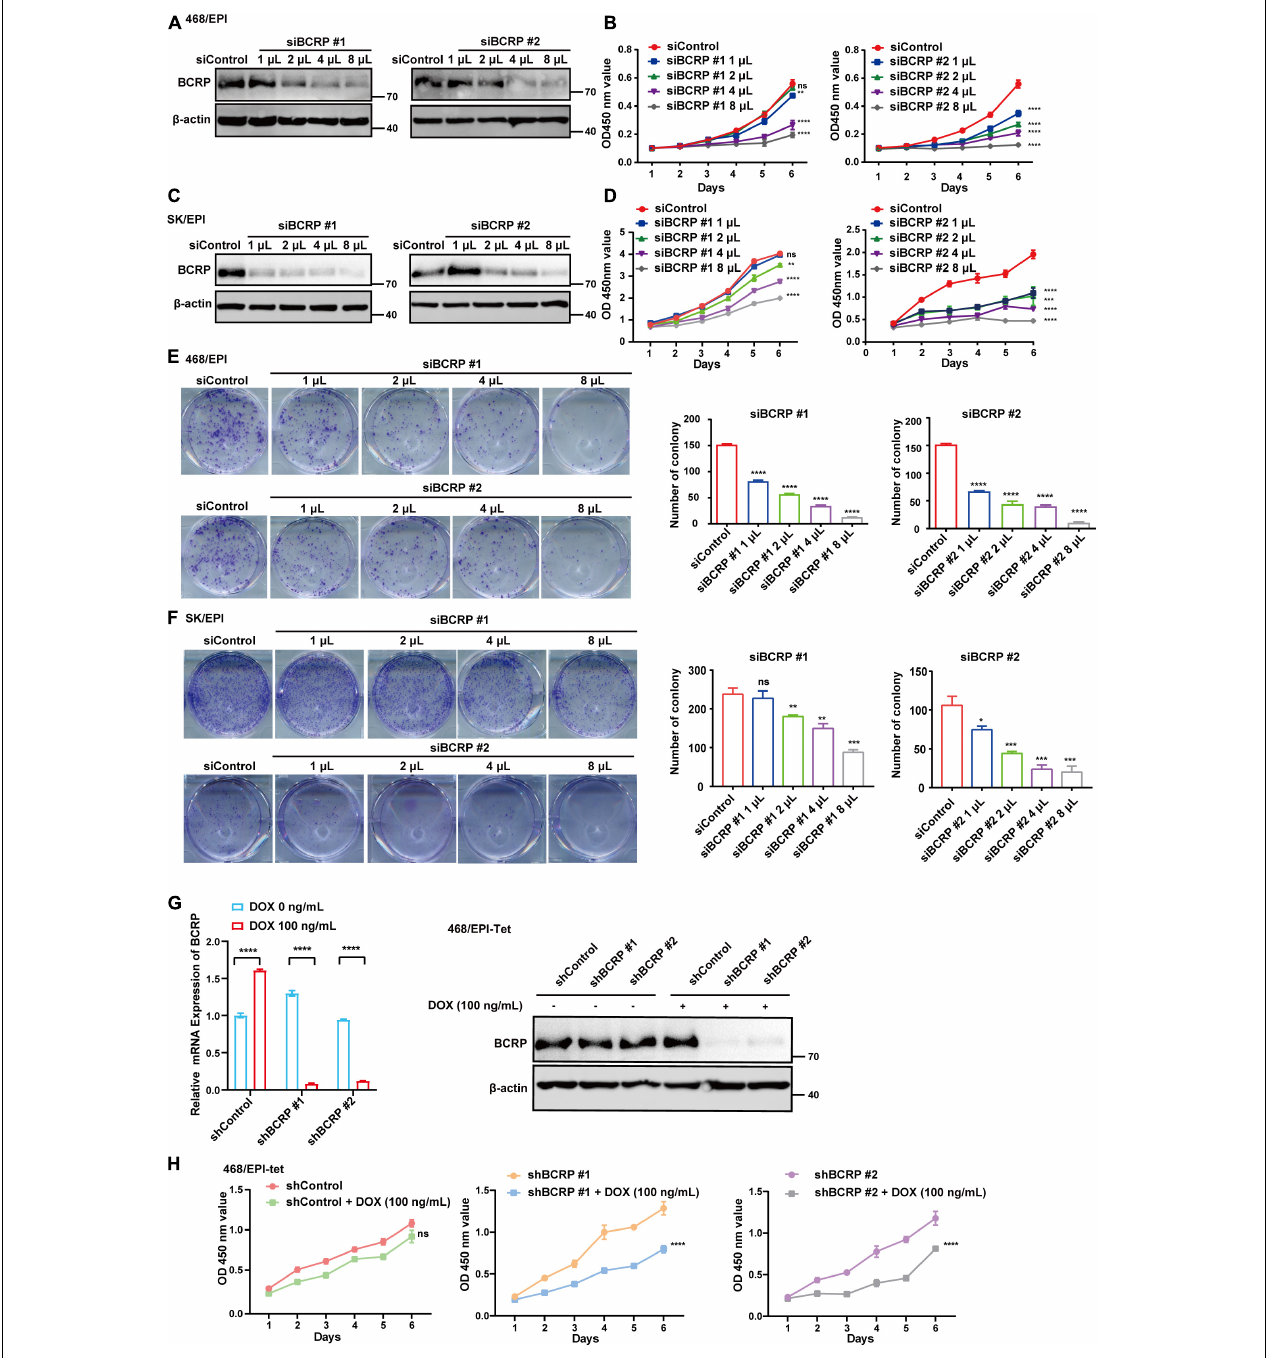
FIGURE 2 | BCRP confers proliferation advantages to drug-resistant breast cancer cells. (A) Western blot analysis of BCRP protein expression in 468/EPI cells treated with increased amount of BCRP siRNAs. (B) Proliferation of 468/EPI cells treated with an increased amount of BCRP siRNAs (two-way ANOVA test). (C) Western blot analysis of BCRP protein expression in SK/EPI cells treated with an increased amount of siBCRP siRNAs. (D) Proliferation of SK/EPI cells treated with an increased amount of siBCRP siRNAs (two-way ANOVA test). For siBCRP #1, 3,000 cells were seeded, and for siBCRP#2, 1,000 cells were seeded. (E) Colony formation ability of 468/EPI cells treated with an increased amount of BCRP siRNAs (independent Student’s t -test). (F) Colony formation ability of SK/EPI cells treated with an increased amount of BCRP siRNAs (independent Student’s t -test). For siBCRP #1, 2,000 cells were seeded, and for siBCRP#2, 800 cells were seeded. (G) Expression of BCRP protein and mRNA in 468/EPI-tet or control cells treated with 100 ng/ml Dox, as shown by qRT-PCR and Western blot analysis (independent Student’s t -test). Results showed that BCRP was successfully silenced by the Dox-inducible shRNA-expressing system. (H) Proliferation of 468/EPI-tet or control cells treated with 100 ng/ml Dox (two-way ANOVA test). All data are shown as the mean ± SD; * p < 0.05. ** p < 0.01, *** p < 0.001, **** p < 0.0001 and ns p > 0.05 versus control, N = 3.